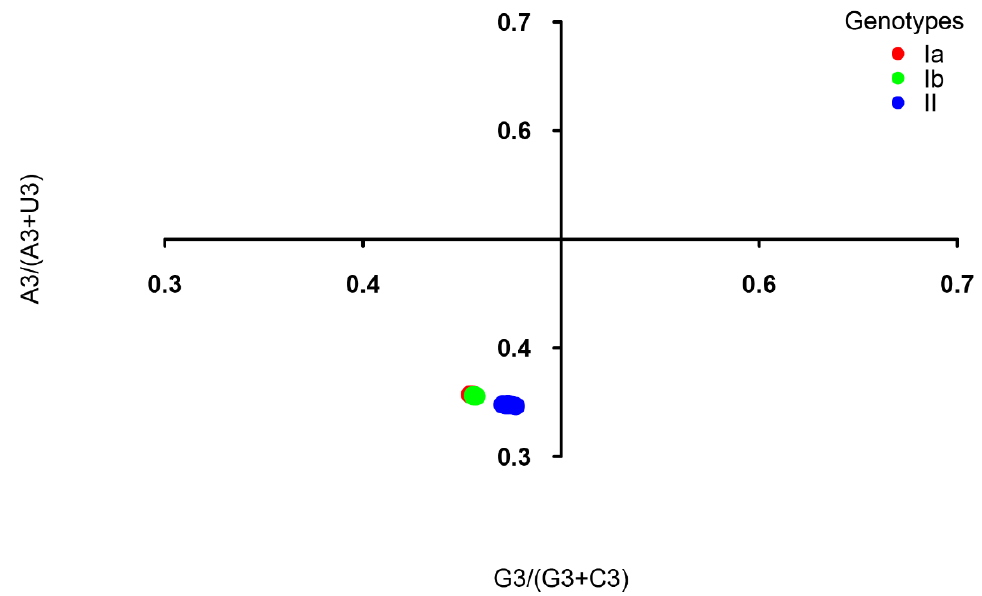
Figure 4. PR2 plot analysis of the TGEV complete CDS. Genotypes Ia, Ib, and II are represented in orange, green, and blue, respectively. G3/(G3 + C3) and A3/(A3 + U3) are horizontal and vertical axes, respectively.